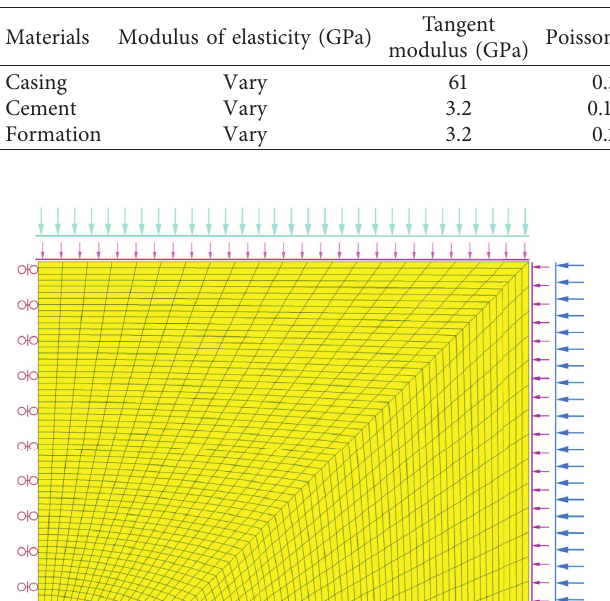
Figure 5: Triaxial test results for cement Table 2: Material parameters of casing, cement and formation.